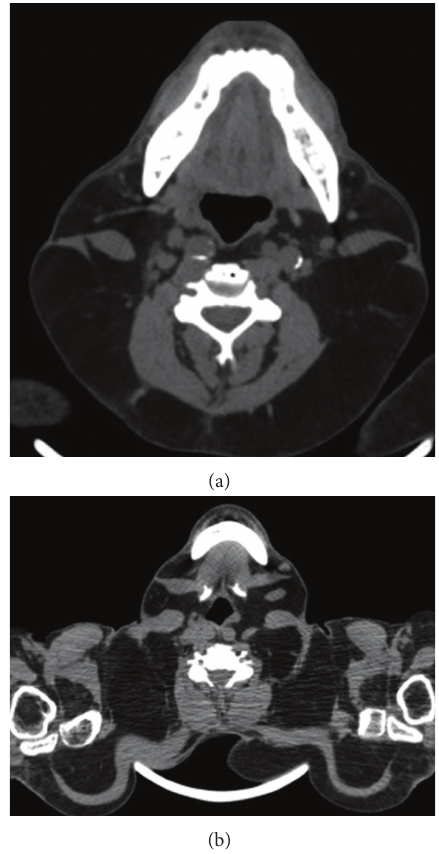
Figure 4: A 53-year-old man with Madelung’s disease presenting a progressive painless increase of the cervical region. CT of the neck and chest showed fat deposition occurring predominantly in the posterior subcutaneous region of the neck (a) and in the supraclav- icular and upper regions of the chest (b).